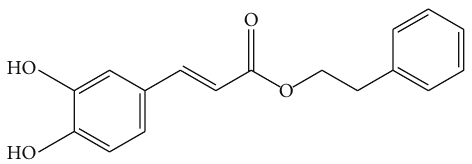
Figure 1: The chemical structure of caffeic acid phenethyl ester (CAPE).